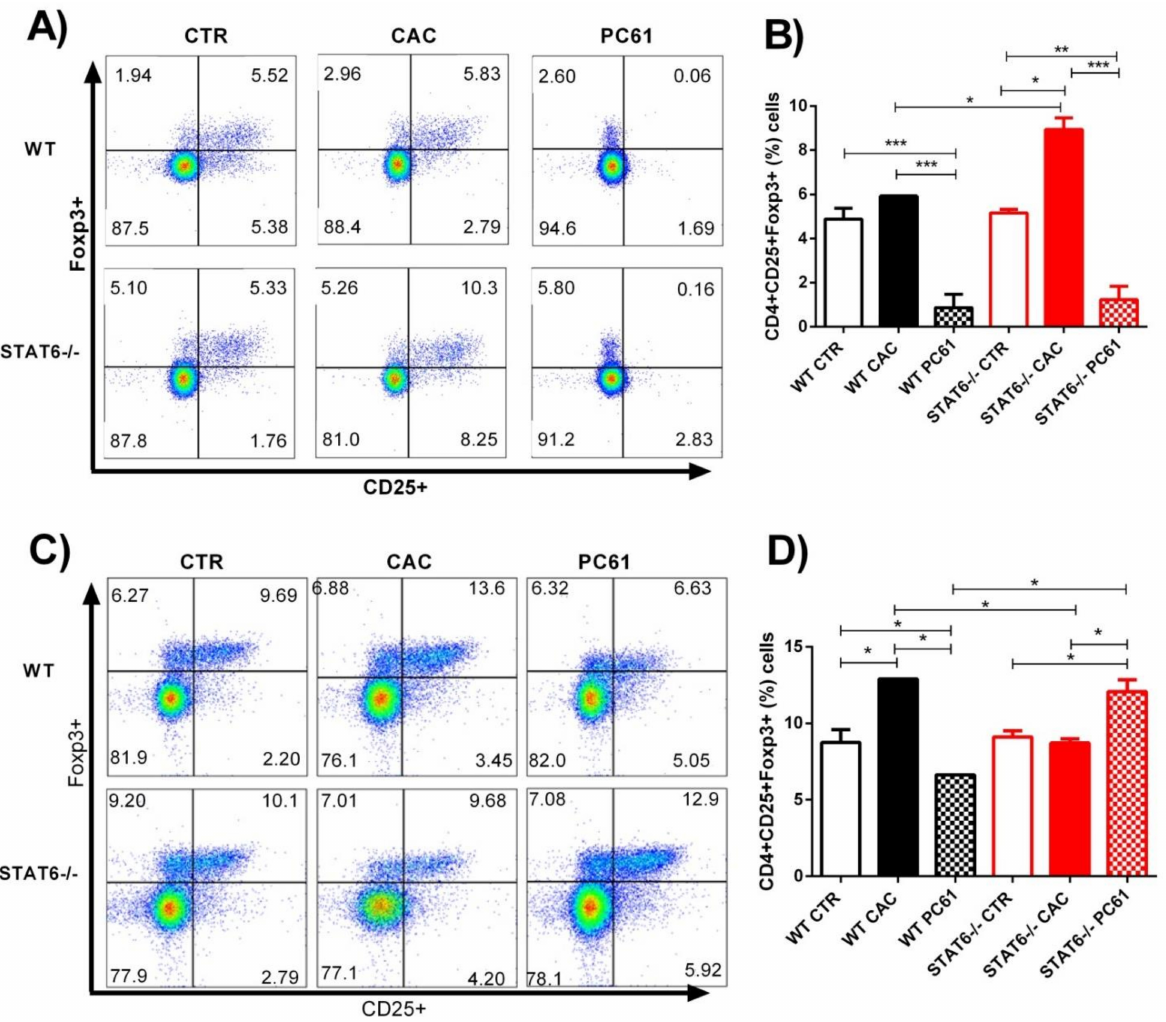
Figure 4. Treatment with anti-CD25 antibody (PC61) during early CAC. The treatment of the mice is shown in Figure 3A. At Day 25 and Day 77, different populations of circulating cells were analyzed by flow cytometry. ( A ) Representative dot plots ( A , C ) and frequencies ( B , D ) of the CD4+CD25+Foxp3+ cells from the WT CAC or STAT6 − / − CAC and PC61-treated WT or STAT6 − / − mice at Day 25 ( A , B ) or Day 77 ( C , D ) after the AOM/DSS administration. The data are expressed as the mean ± SEM and are representative of two independent experiments, with at least three mice per group per day of the analysis. * p < 0.05, ** p < 0.01, *** p <